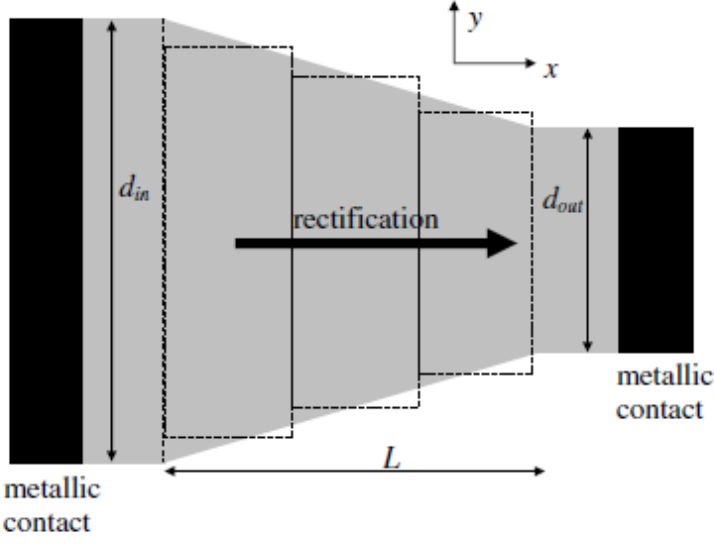
Figure 8. Schematic representation of the ballistic rectifier (Reproduced with permission from [74], IOP Publishing,